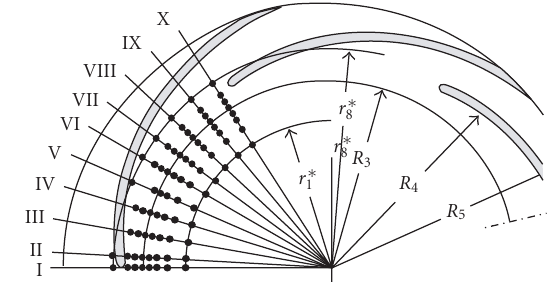
Figure 2: The ten angular and radial positions relative to di ff user vane for LDV